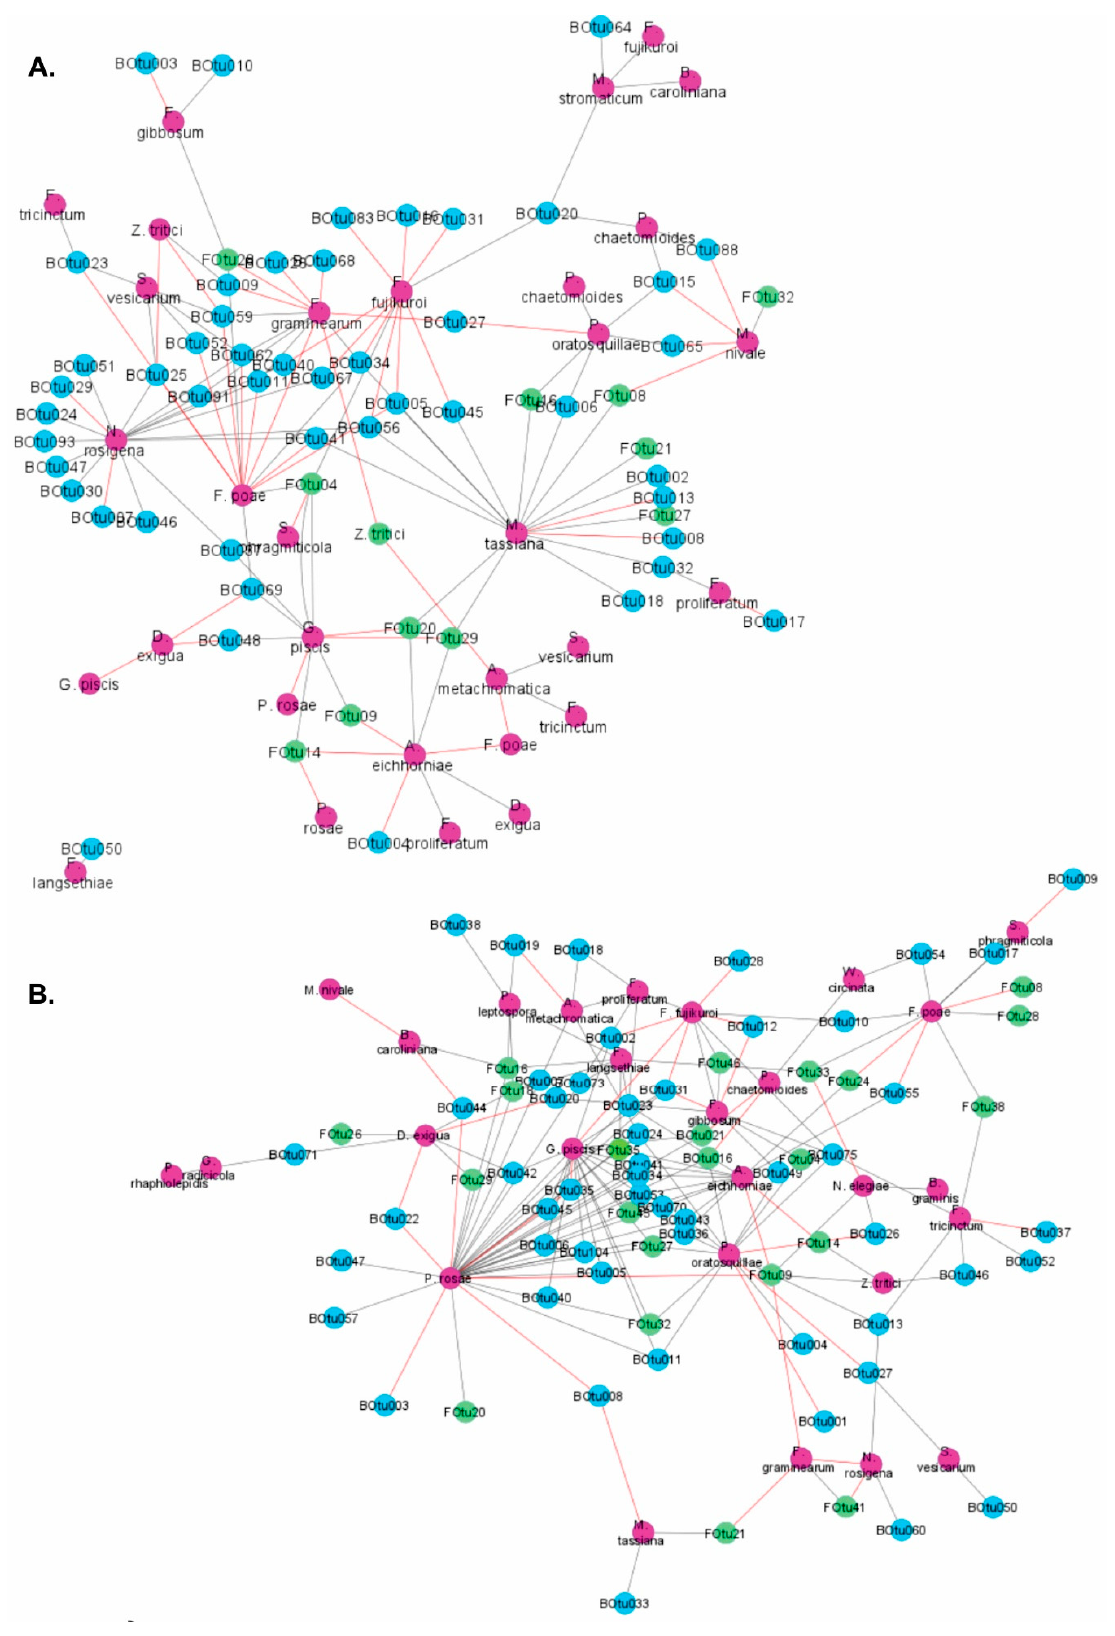
Figure 2. Networks of co-occurring microbial operational taxonomic units (OTUs) colonizing wheat straw residues under ( A ) ambient and ( B ) future climate treatments. Edges colored in black represent positive co-occurrence relationships, while edges in red represent negative co-occurrence